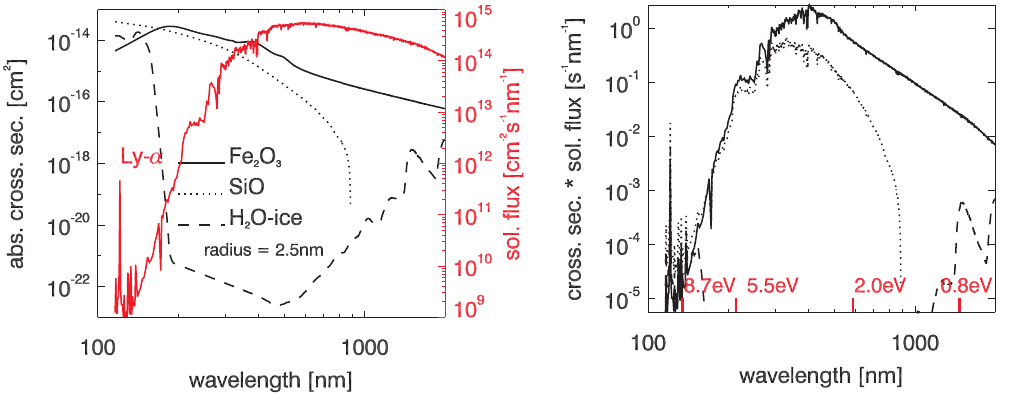
Fig. 1. Left panel: Wavelength-dependence of the absorption cross sections for spherical particles composed of hematite (Fe 2 O 3 , solid line), silicon oxide (SiO, dotted line), and water ice (dashed line), for a particle radius of 2.5nm (left ordinate), and the solar spectrum at mesospheric heights (right red ordinate). Right panel: Corresponding products of absorption cross sections and the solar flux. Note that values for all materials fall close on each other at wavelengths around Ly- α . In addition, threshold-energies for the photoionization of water ice (8.7eV) and Fe 2 O 3 (5.5eV), as well as the electron affinity of water ice (0.8eV) and Fe 2 O 3 (2eV) have been indicated by vertical red lines on the abscissa.